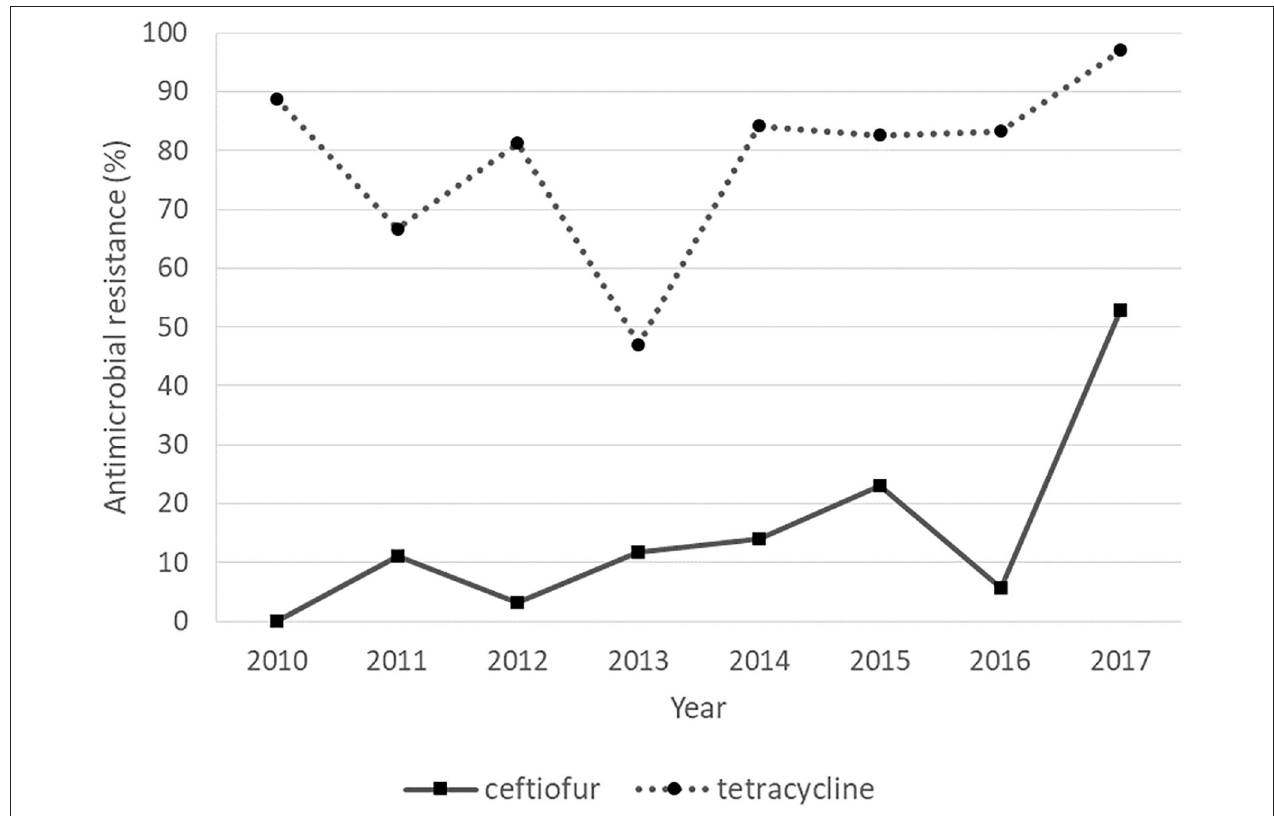
FIGURE 2 | Antimicrobial resistance of Streptococcus uberis with “increasing” trends over a period of 8 years, from 2010 to 2017.